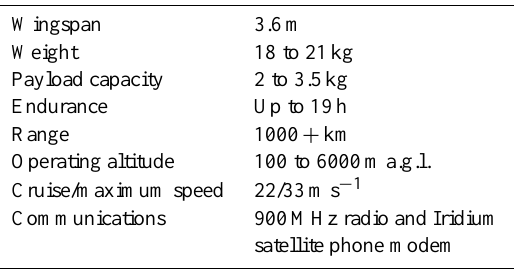
Table 1. Aerosonde UAS